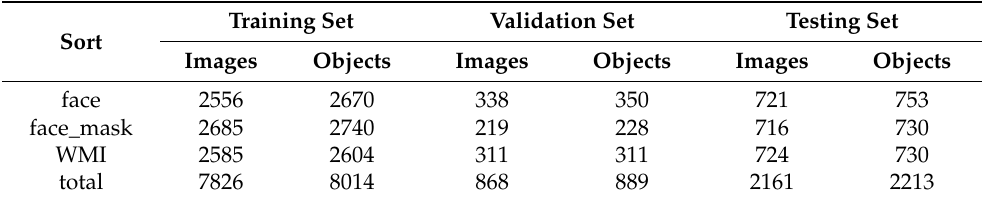
Table 2. Distribution of different types of samples in the data